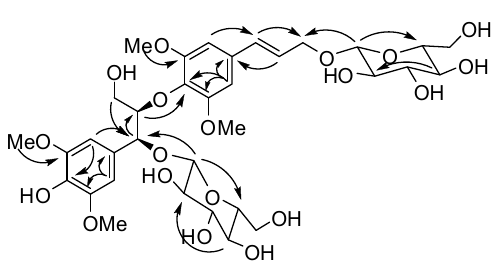
Figure 2. Key HMBC correlations of 1